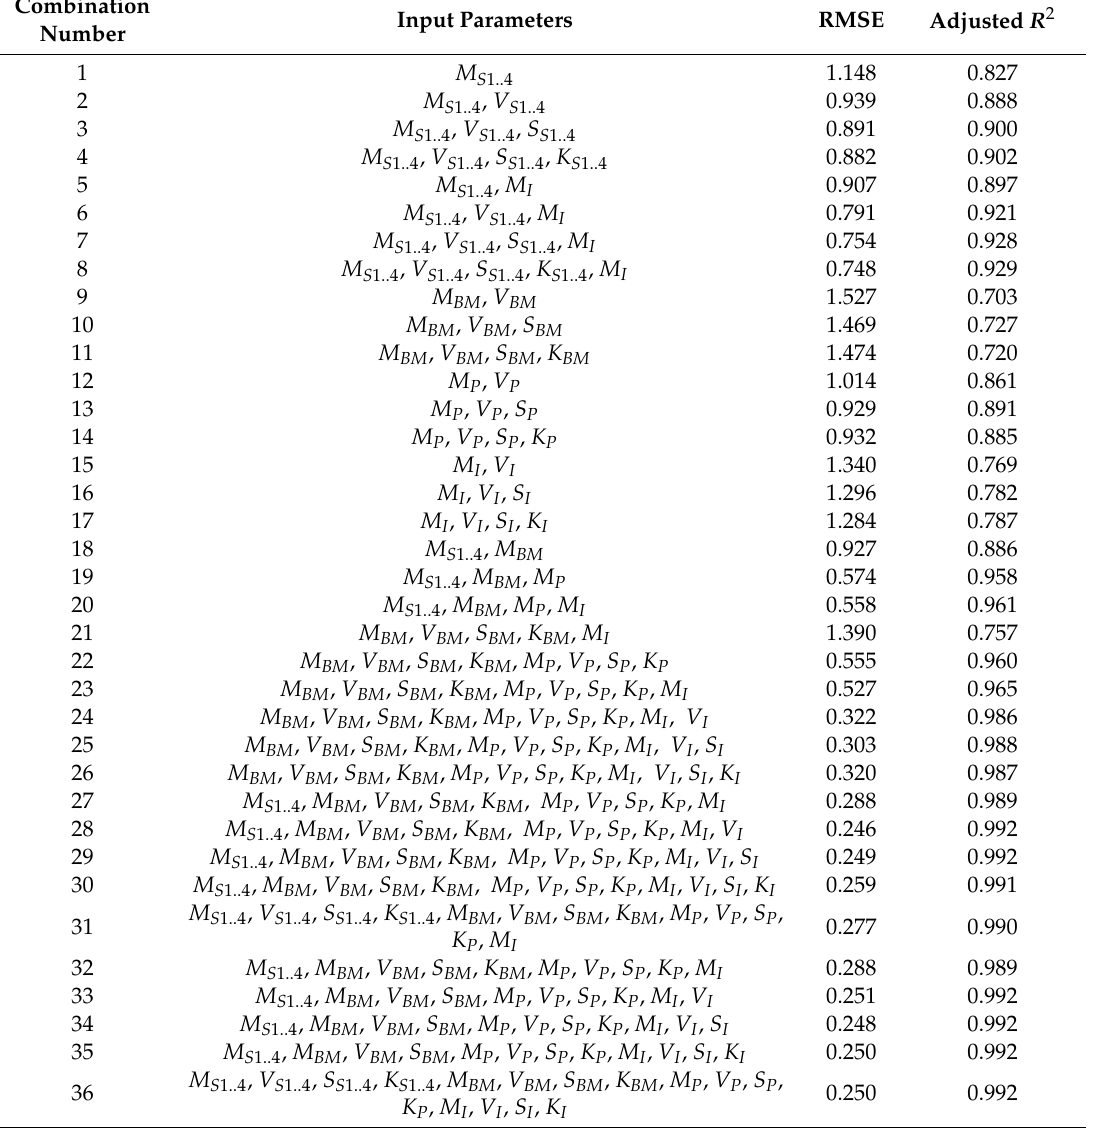
Table 1. Data for di ff erent combinations of input parameters for prediction of denoising e ffi ciency for I-PSNR.